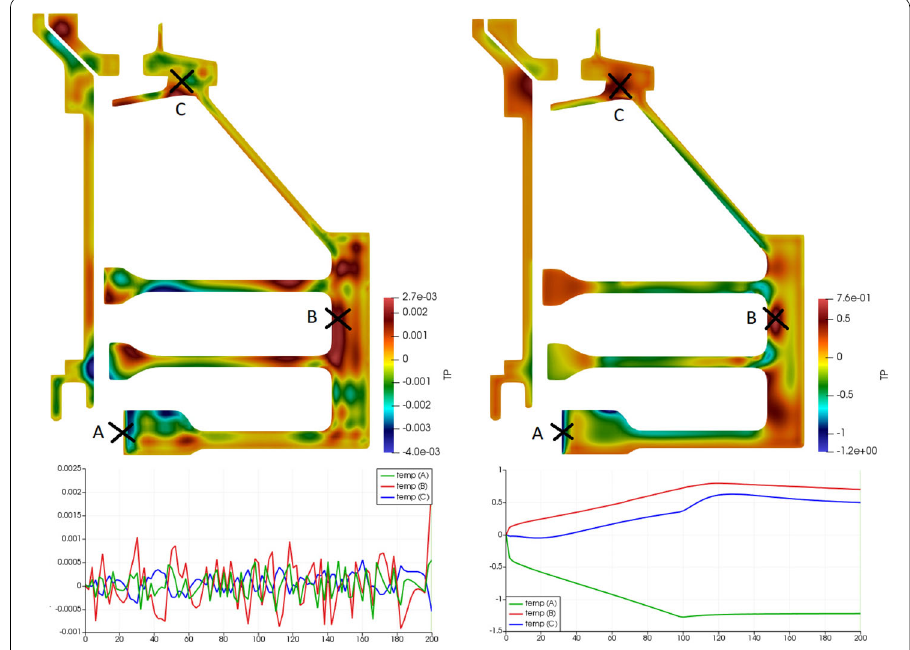
Fig. 9 Absolute error between the HFM and the ROM at the last time step (top) and over time on three nodes (bottom) using Z-set generated snapshots (left) and Abaqus generated snapshots